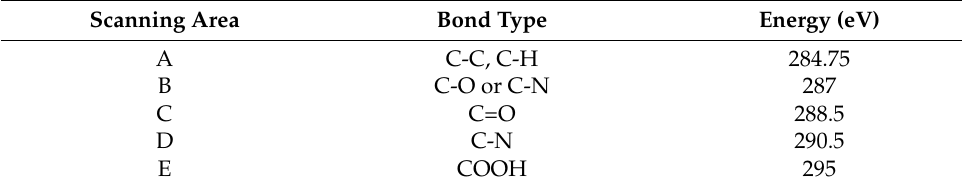
Table 1. C(1s) XPS analysis.